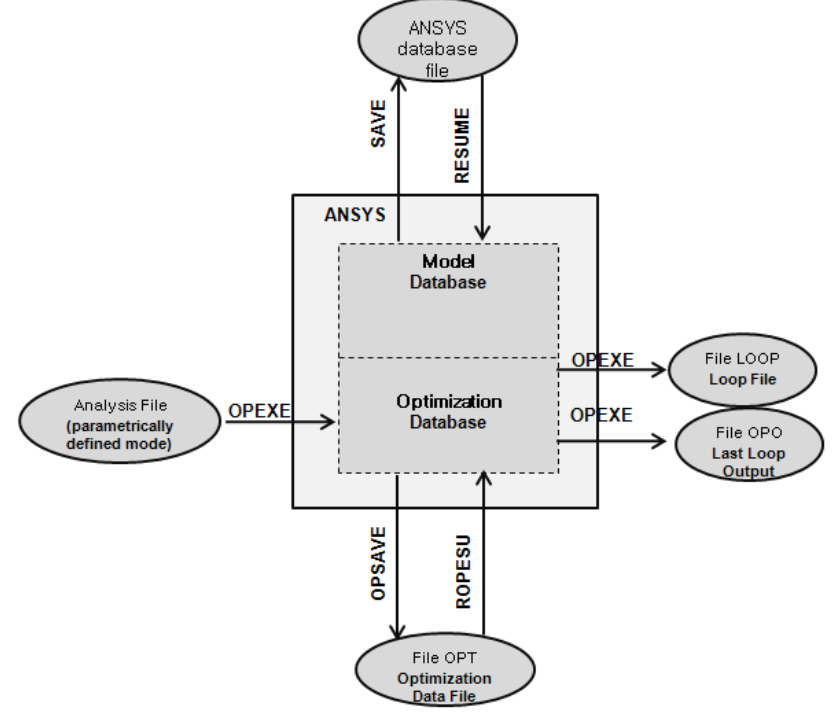
Figure 8. Optimization data flow.